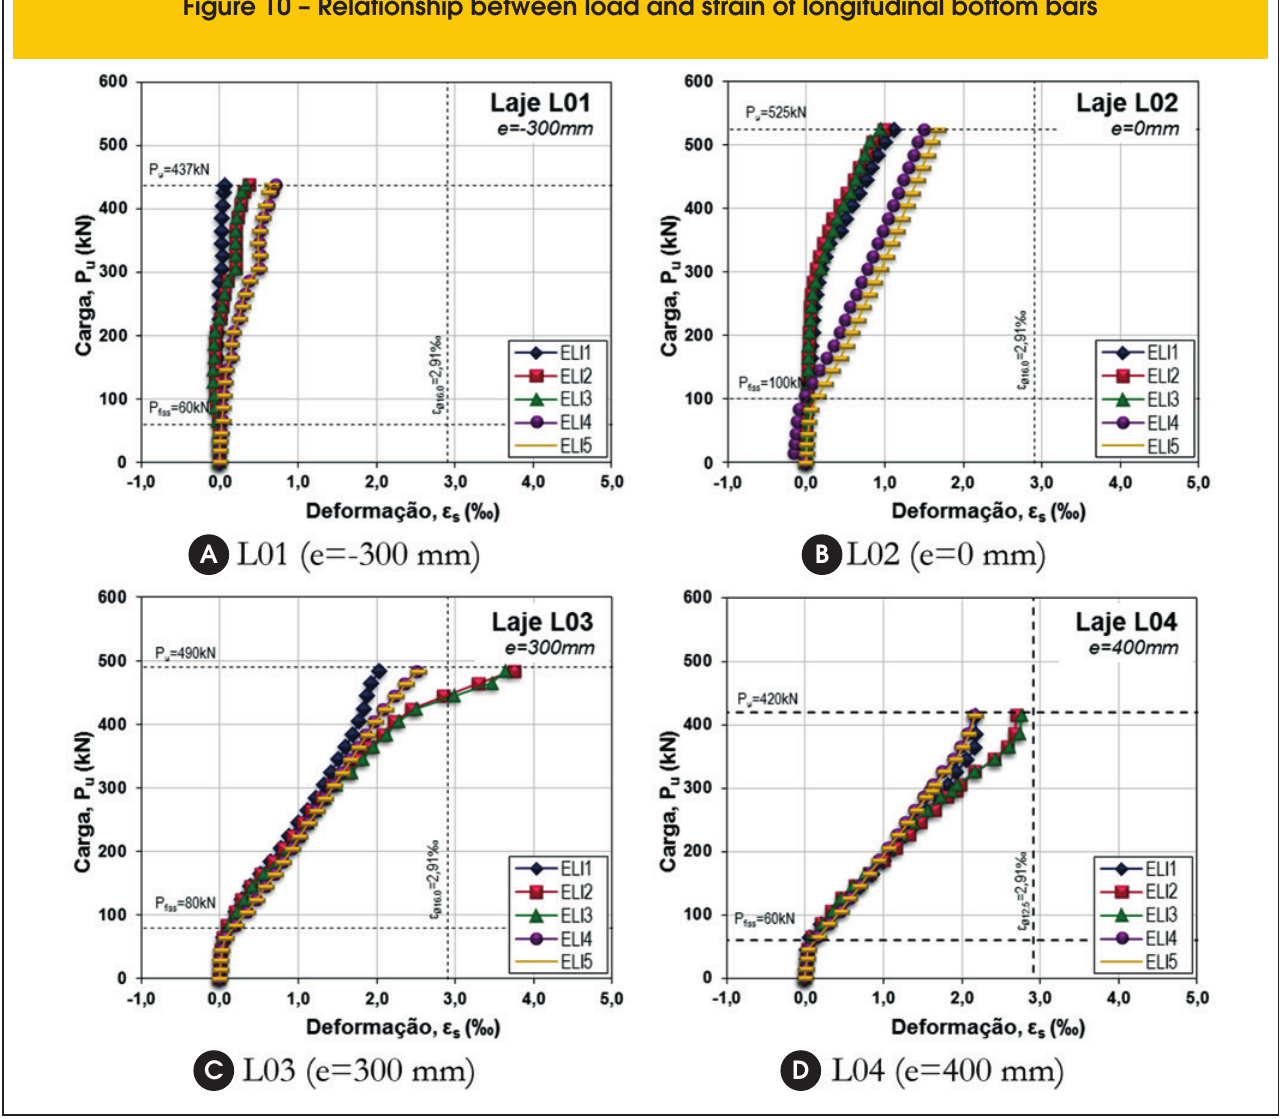
Figure 10 – Relationship between load and strain of longitudinal bottom